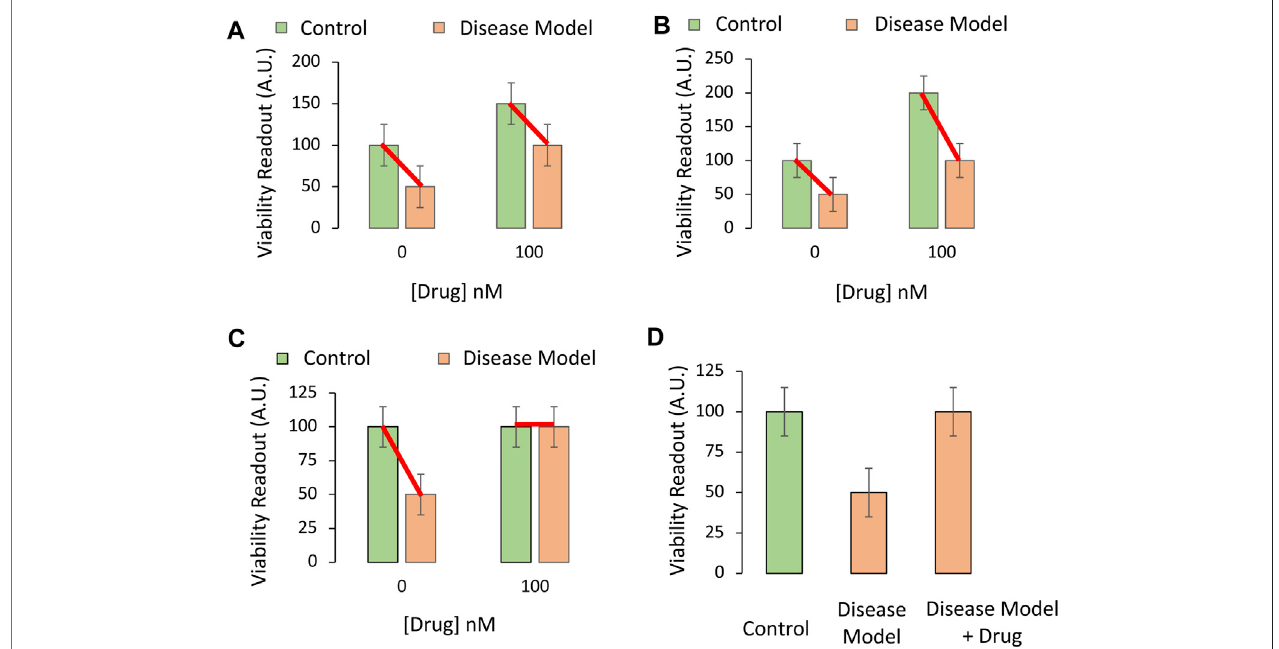
FIGURE3| Testingifthepharmaceuticaldrugcandidatemodi fi estheimpactoftheexperimentaldiseaseoncellularviability invitro . (A,B) Thedrugcandidateraises theviabilityofculturedcellsattheindicatedconcentrationof100 nM(chosenfrom Panels2A,B ),regardlessofexperimentaldisease(orangebars)orcontrol(greenbars) conditions. The drug only raises baseline viability; it does not truly protect cells against the loss of viability under disease conditions, even if the two orange bars are signi fi cantlydifferentin posthoc pairwisecomparisontests. (C) Thedrugcompletelypreventsthelossofcellularviabilitywithdiseaseattheindicatedconcentration. The impact of the experimental disease on cellular viability is therefore modi fi ed by the drug candidate. (D) If one of the control groups is not included [second green bar from panel (B) is missing], the data might appear as shown in this panel. This drug candidate may fail to modify the toxic impact of disease, but that would not evident from these three groups alone. If the primary readout involves pathological markers that are truly absent (zero) in the non-diseased control group, then the experimental design in panel (D) and a one-way ANOVA might be suf fi cient to test the hypothesis.